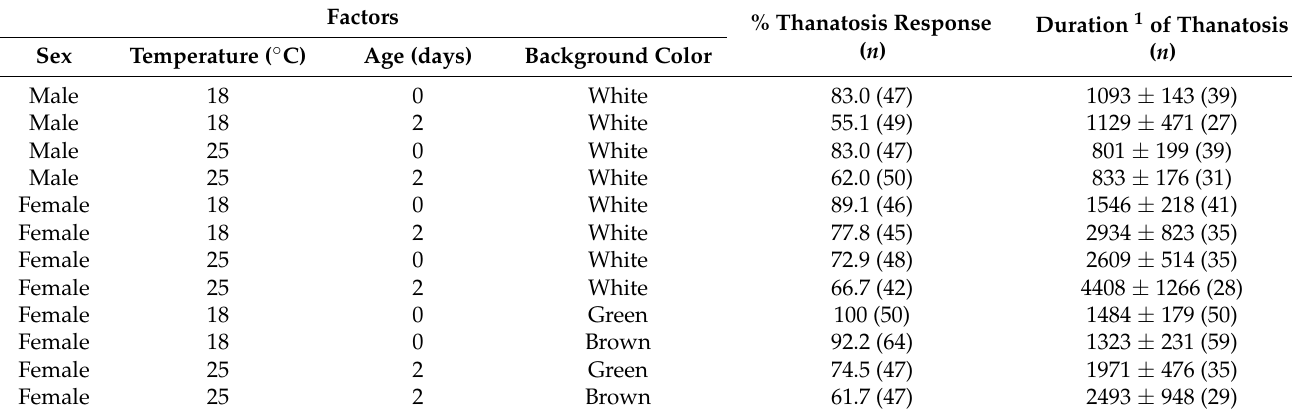
Table 1. Frequency and duration of thanatosis in Heterospilus prosopidis under various treatments. Factors % Thanatosis Response